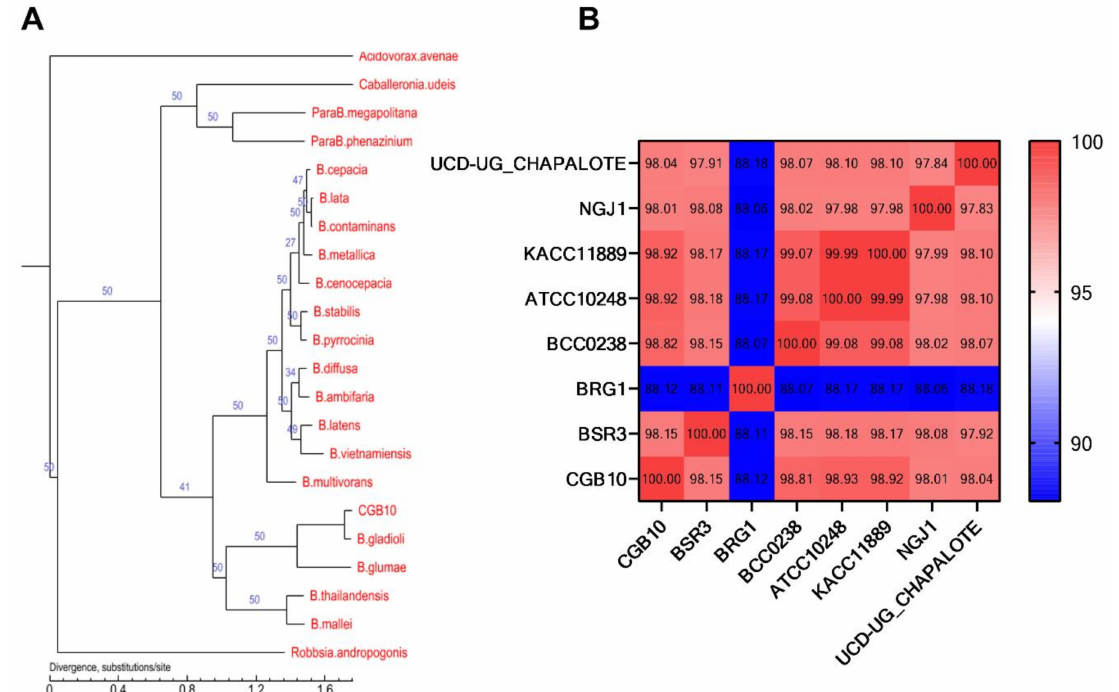
Figure 1. Phylogenic analysis of CGB10. ( A ) Phylogenic analysis based on single-copy core genes. The number on the branch indicates the reliability of the branch, and the closer the value to 50, the higher the reliability; the length of the branch indicates the size of the evolutionary distance, which is calculated by the average number of substitutions of each amino acid. ( B ) ANI analysis based on the whole genome of the CGB10 strain in comparison with six selected B. gladioli strains and a B. glumae strain